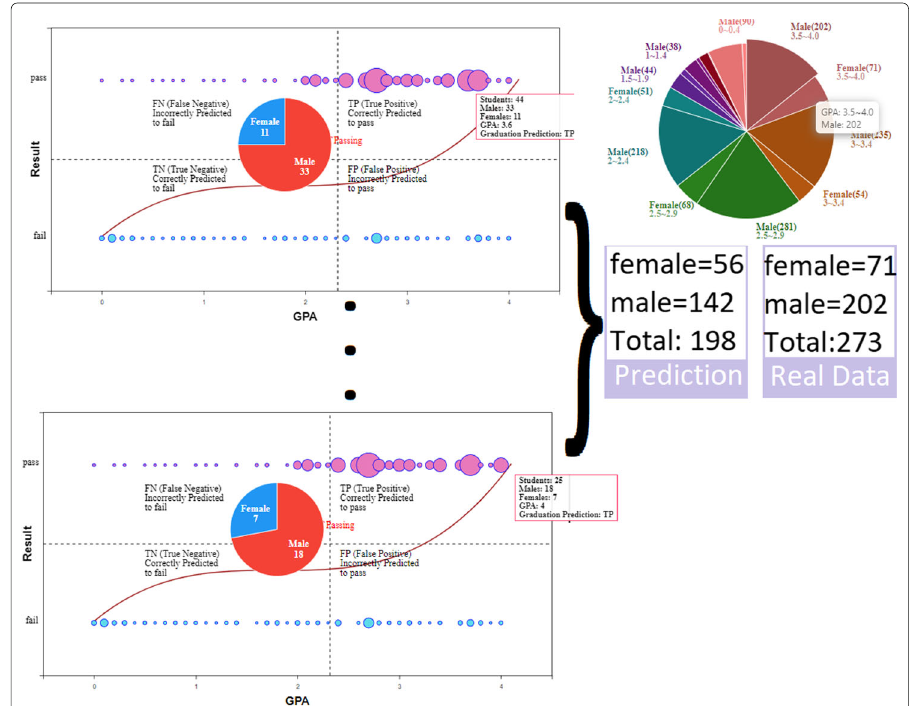
Fig. 26 Logistic Regression analysis for True positive prediction (passed successfully and correctly predicted)